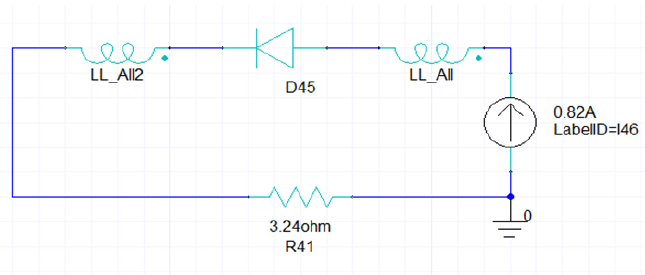
Figure 5. External circuit for rotor field windings under DC excitation.